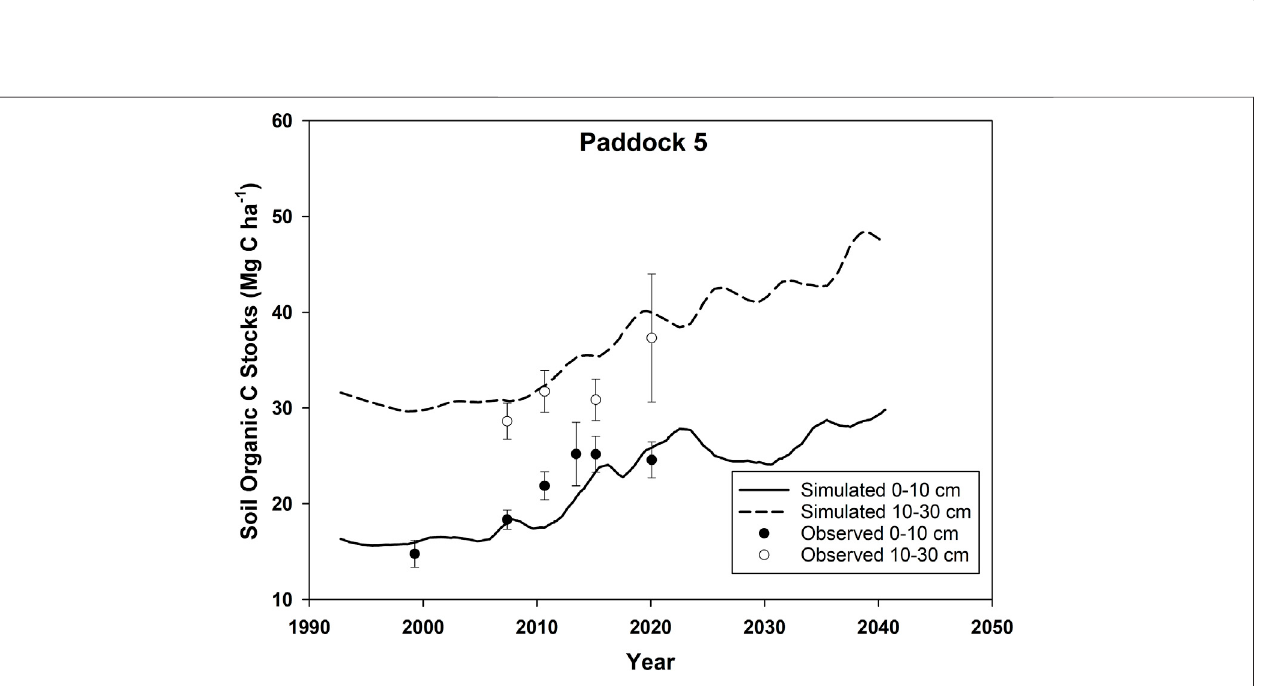
Frontiers in Environmental Science |